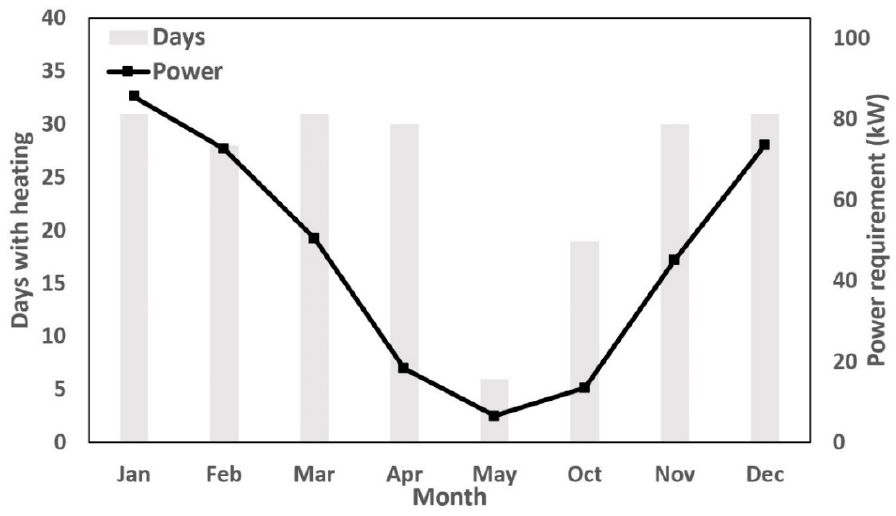
Figure 2. Annual variation in the power required to keep the greenhouse at 12 °C during the days with heating needs.